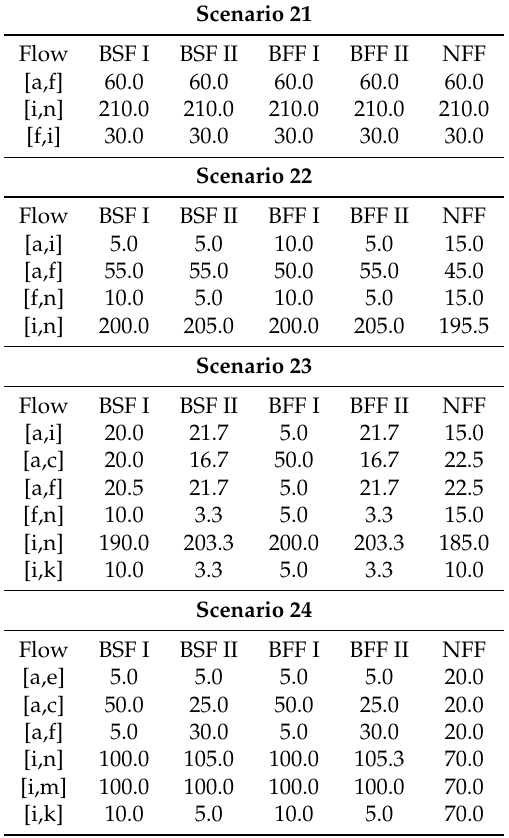
Table 7. Flow set and LP results for the flows’ end-to-end throughput for scenarios 21 to 24 described in Figure 18. All values in